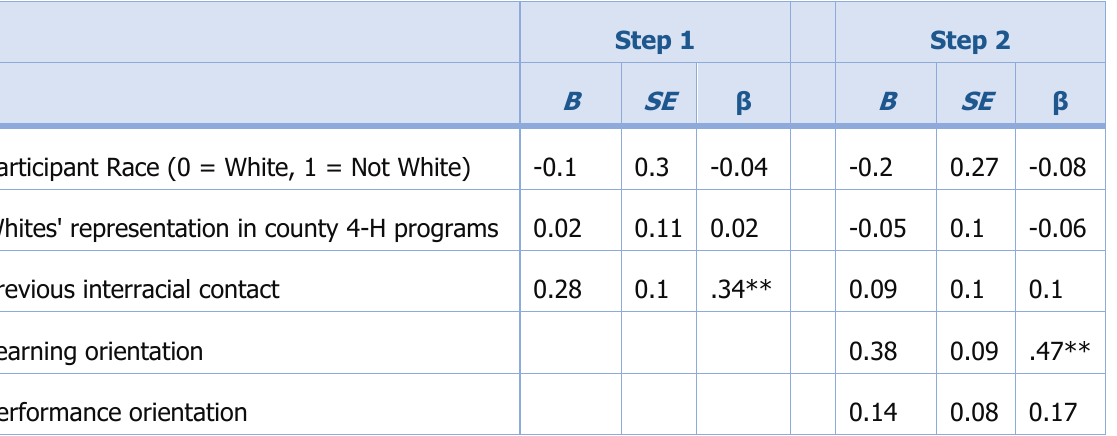
Table 2. Hierarchical Linear Regression Predicting Endorsement of Diversity and Inclusion in